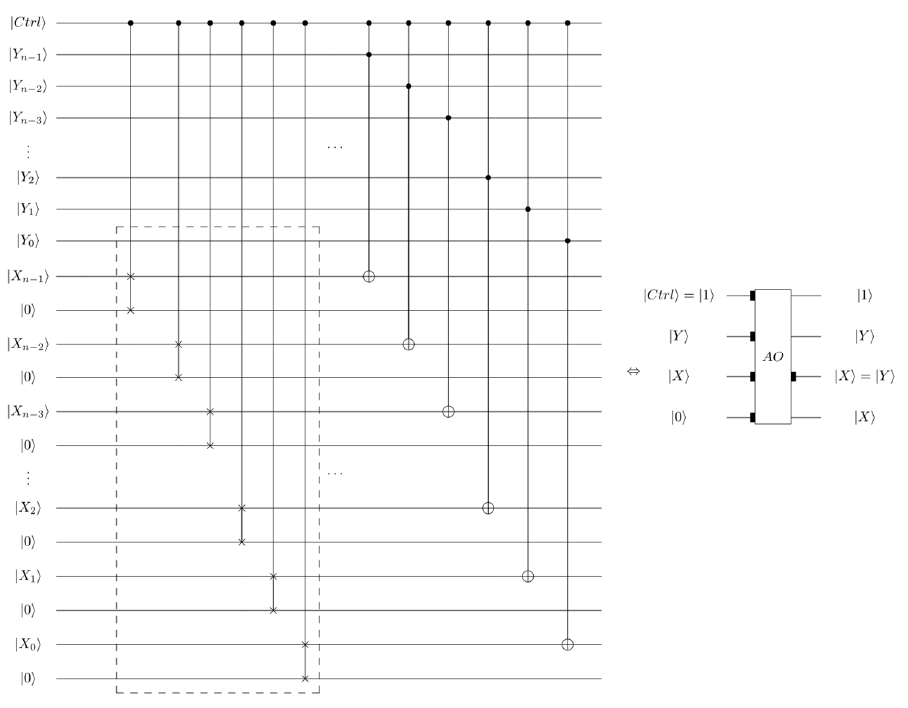
Figure 6. Assignment operation circuit.